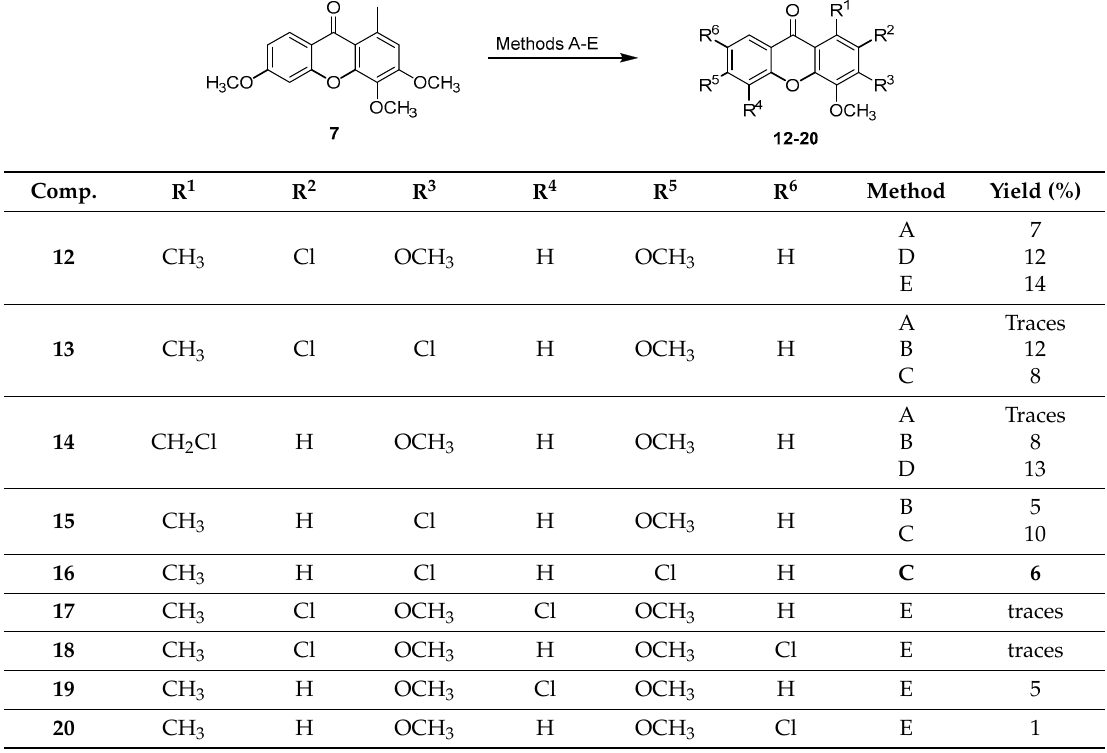
Table 2. Synthesis of chlorinated derivatives of 3,4,6-trimethoxy-1-methyl-9 H -xanthen-9-one ( 7 ).